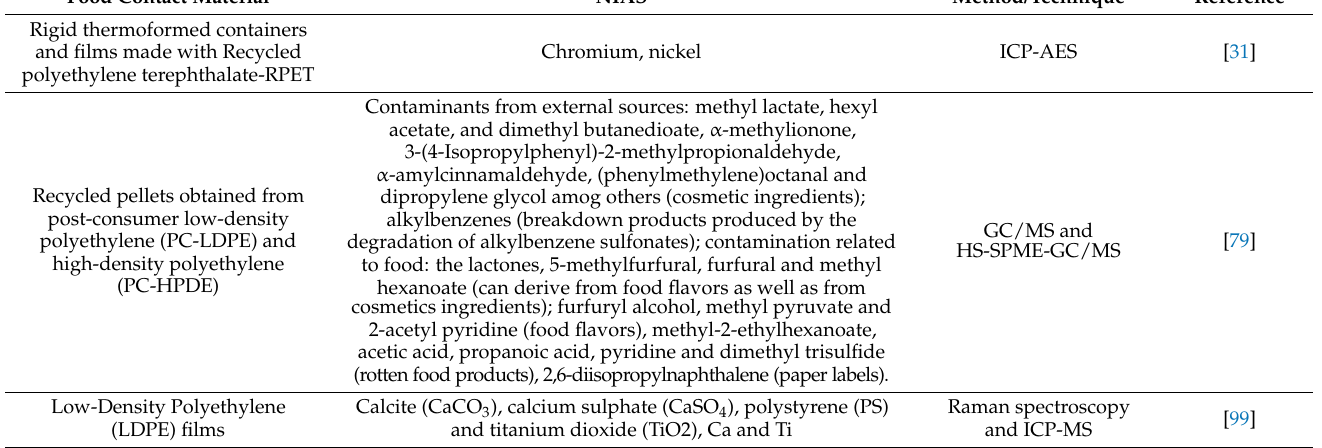
Low-Density Polyethylene (LDPE)